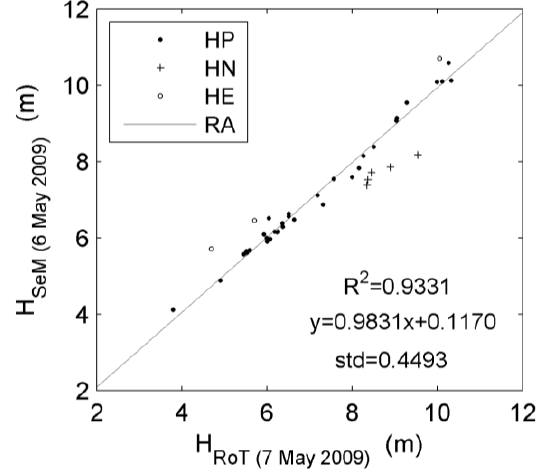
Figure 7. Scatterplots of the tree heights derived from the SeMM and RoT data. See text for the definition of